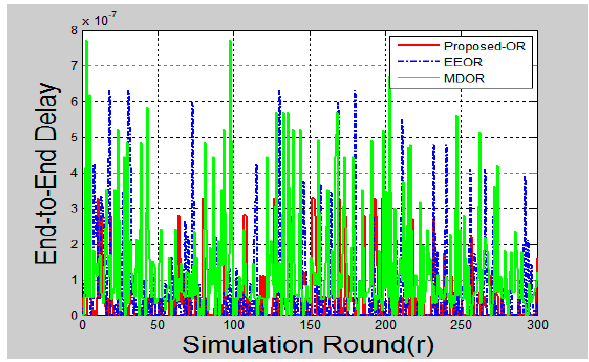
Figure 6. End-to-end delay.